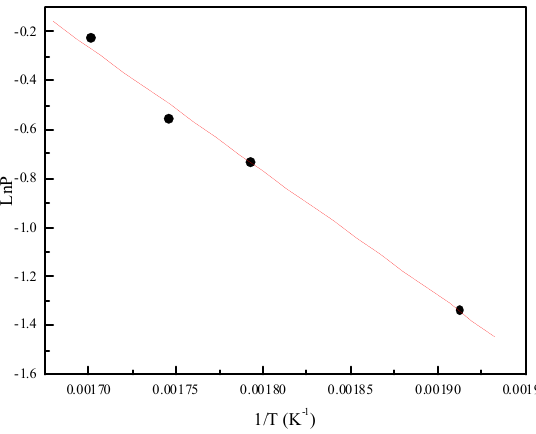
Figure 5. The van’t Hoff plot of the alloy in hydrogenation processes.